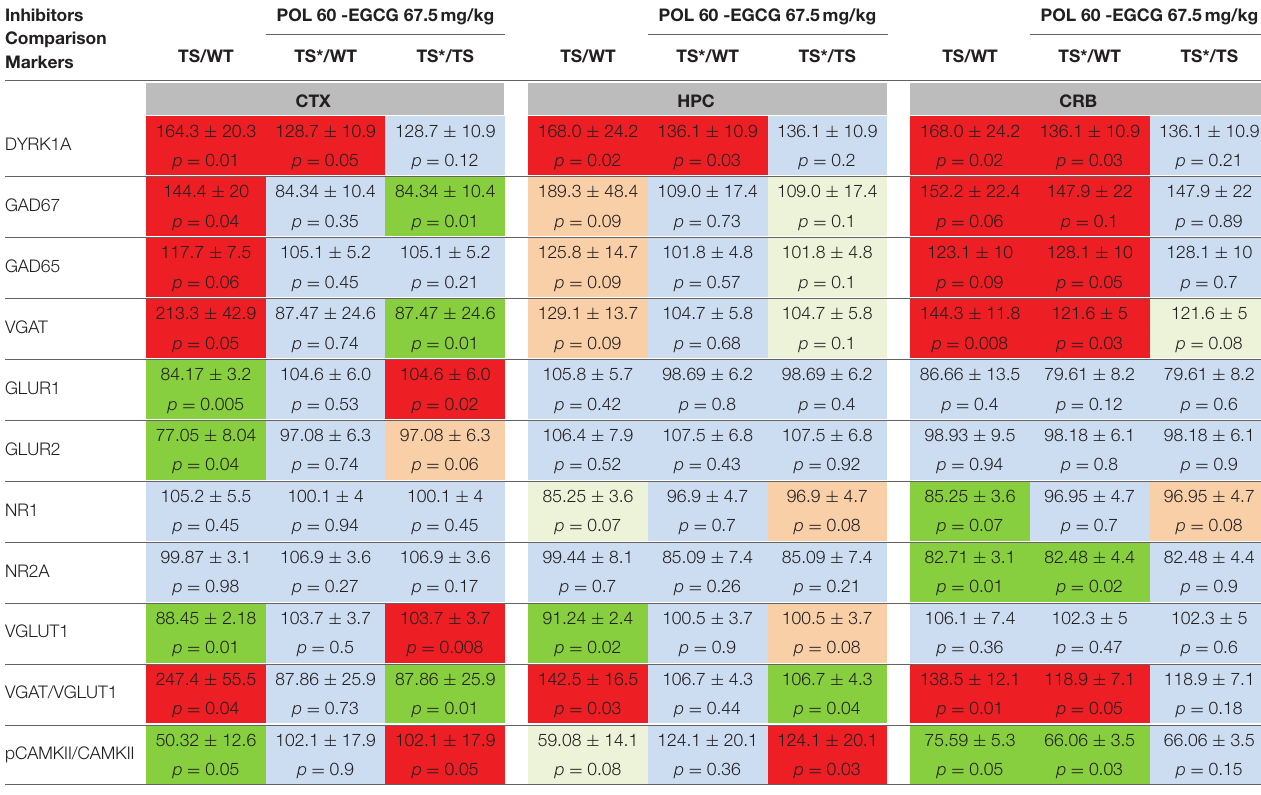
TABLE 2 | Protein levels of markers of inhibition and excitation pathways for WT and Ts65Dn (TS) in cortex, hippocampus, and cerebellum following treatment with POL60 extract. Inhibitors Comparison